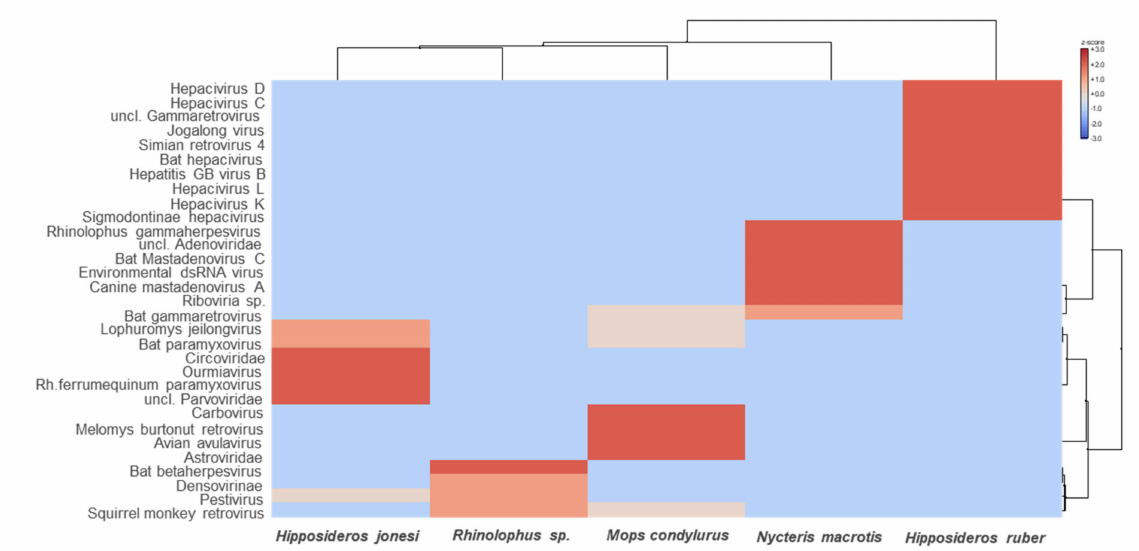
Figure 3. Heat map visualizing the most abundant virus species in each pooled bat sample. The bat species are listed in the bottom text row. The names of the virus species are presented in the left text column. Heat maps are color-coded based on row